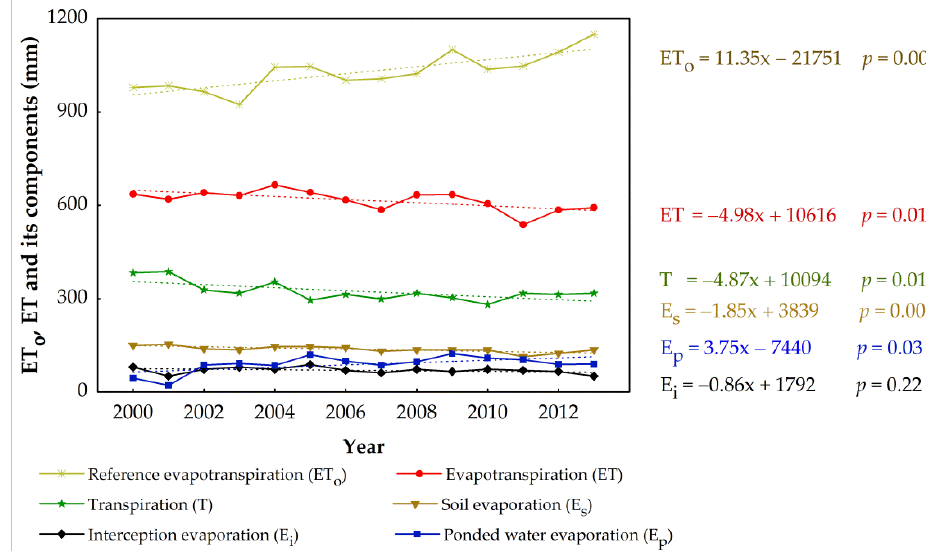
Figure 5. Trend of annual watershed-level reference evapotranspiration (ET o ), evapotranspiration (ET), and its partitioning in the Qinhuai River Basin from 2000 to 2013.